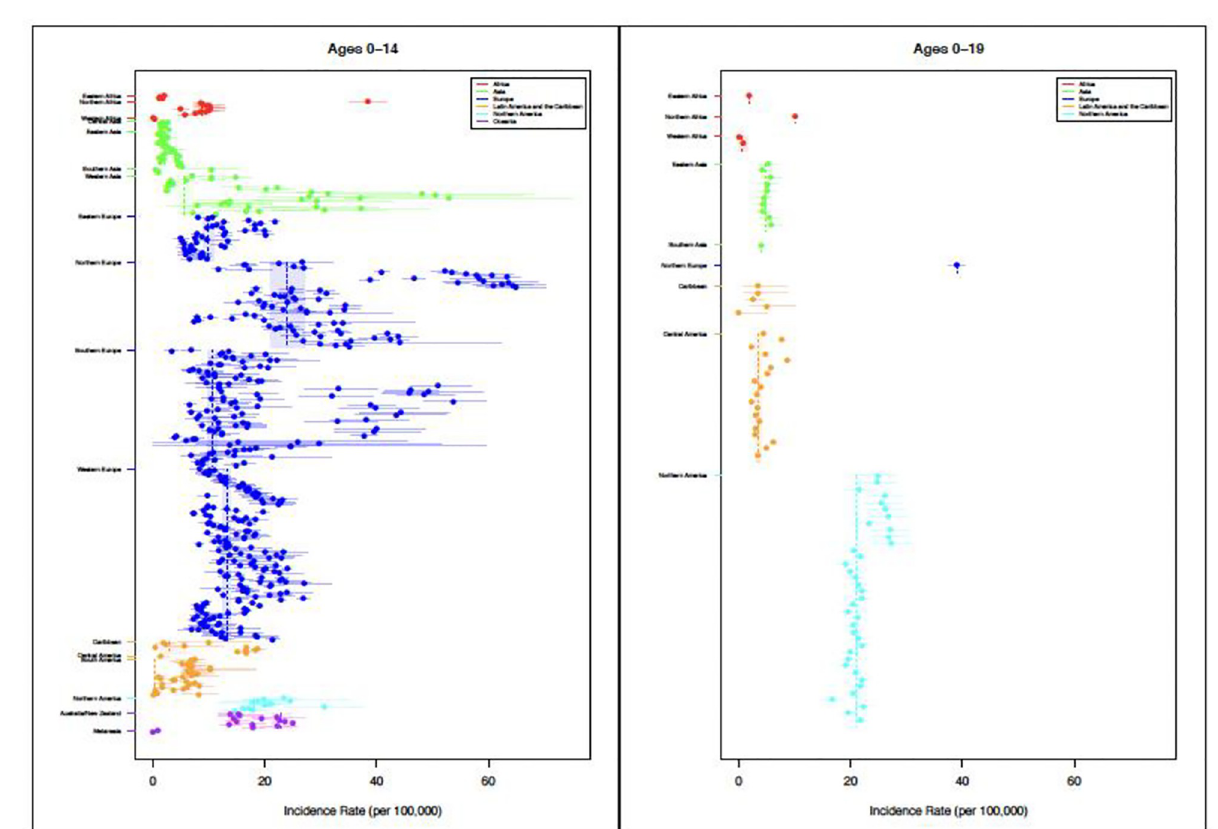
Fig 2. Variation in TlD incidence rates for age groups 0–14 and 0–19 years by region. [Point sizes are proportional to their weight (i.e. inverse variance). The lines indicate means and shaded areas indicate 95%